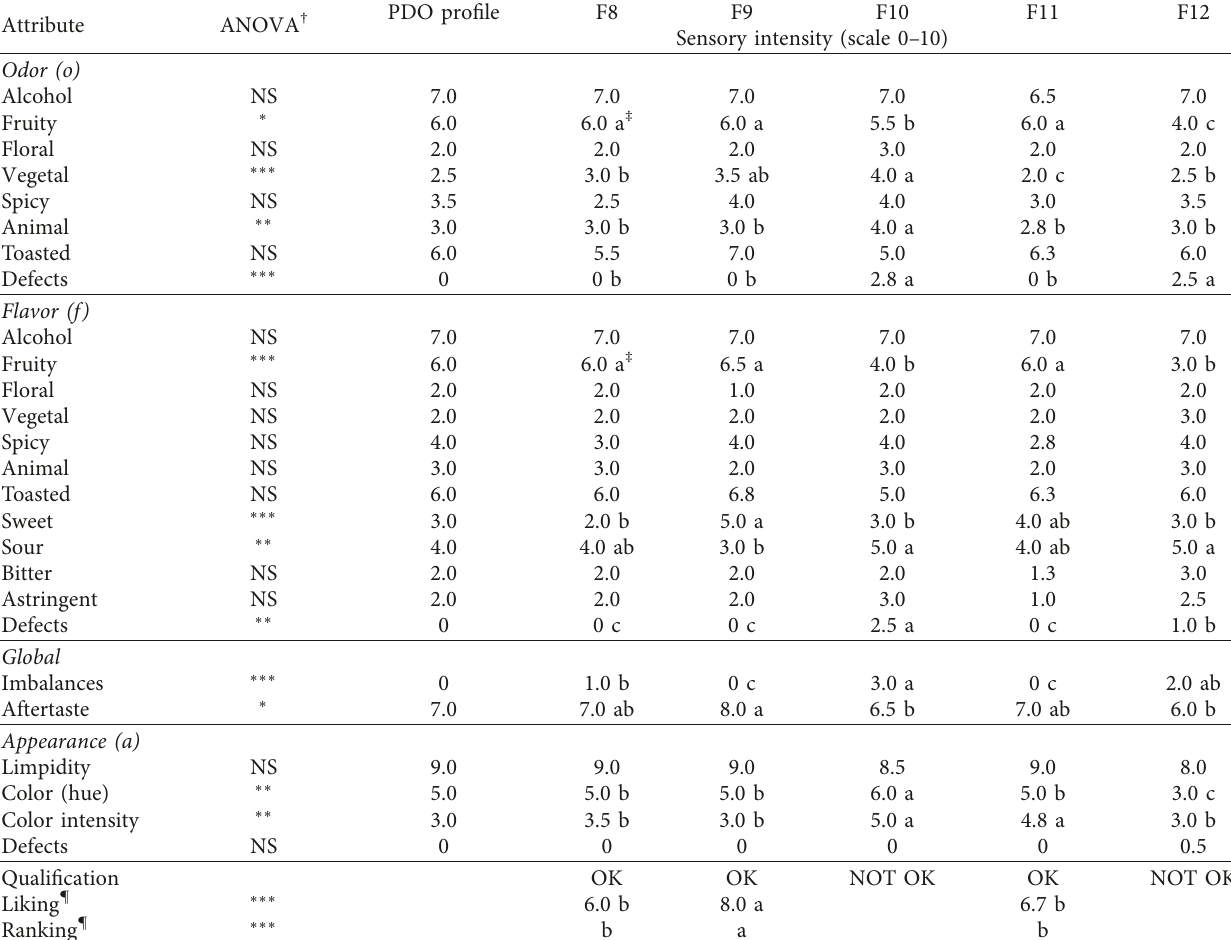
Table 4: Descriptive sensory analysis of commercial samples of Fondill´on used to validate the sensory